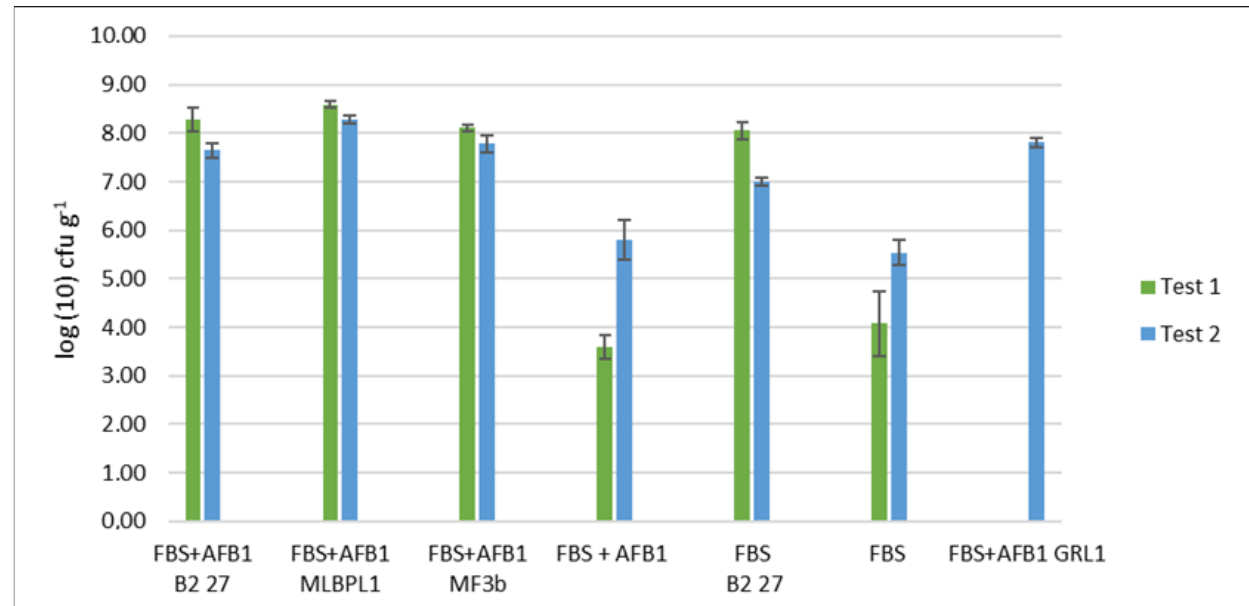
Figure 2. Growth of lactic acid bacteria (LAB) in fava bean suspension (FBS) and FBS spiked with 10 mg/kg aflatoxin B1 (AFB1). The columns show an average of three parallel cultivations, and vertical bars represent standard deviation of the mean. With the exception of L. brevis GRL1, the experiments were performed as two independent tests.